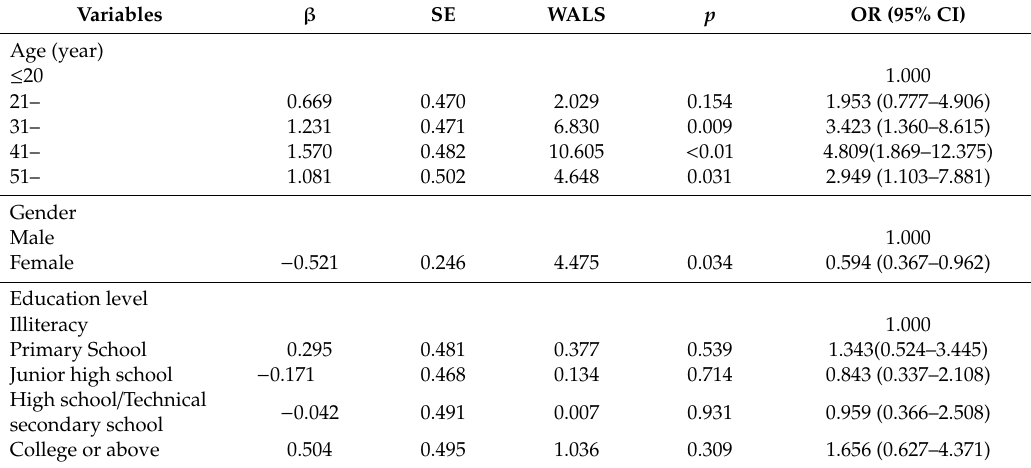
Table 5. Univariate and multivariate logistic regression analysis of factors a ff ecting TP infection in 1018 HIV-infected patients in Shaanxi